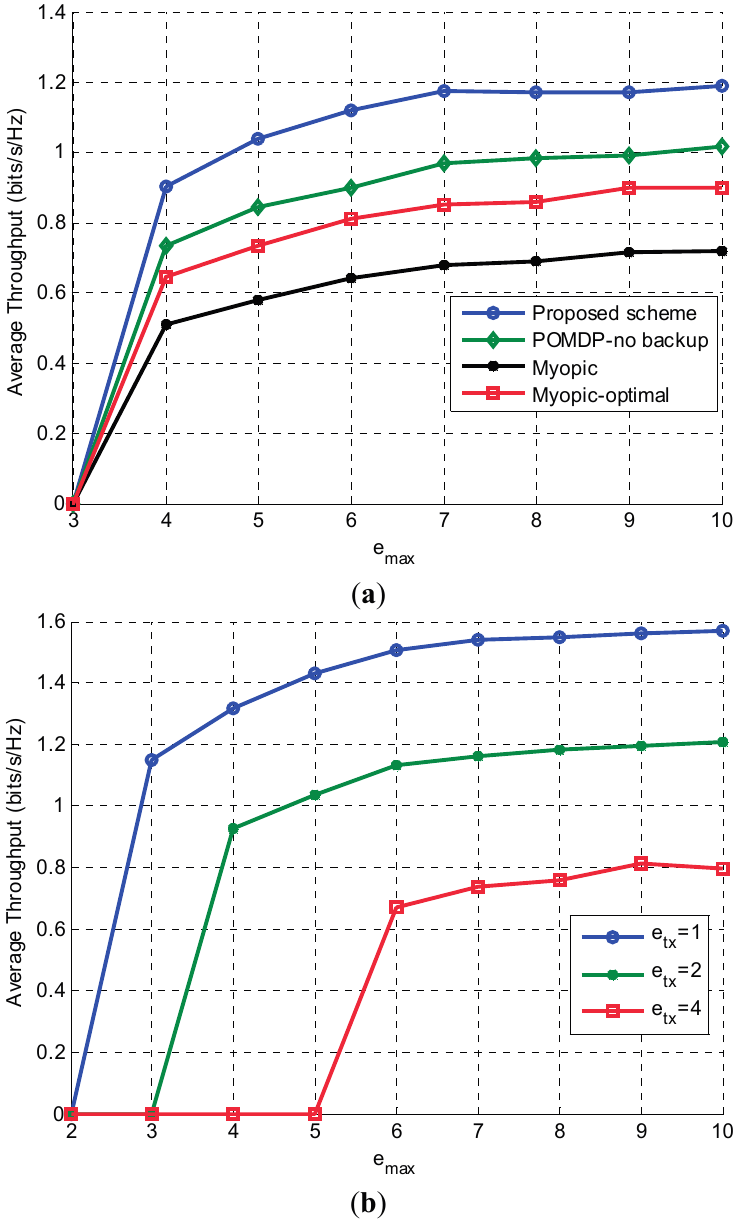
Figure 6. ( a ) Effect of battery capacity on average throughput when (cid:1842) (cid:1857) = 2, (cid:1857) = (cid:1857) = 0.5, (cid:1857) = 2 ; ( b ) Effect of transmission energy on average (cid:3047) (cid:3046) (cid:3046)(cid:3050) (cid:3040)(cid:3032)(cid:3028)(cid:3041) throughput for different values of (cid:1857) (cid:3040)(cid:3028)(cid:3051)